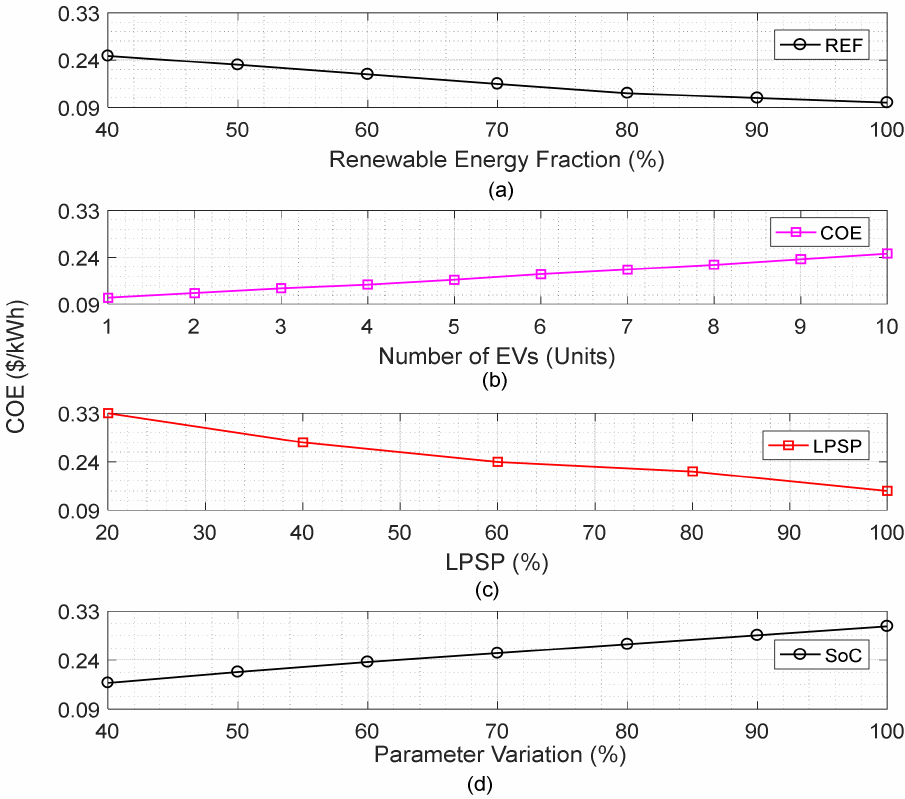
Figure 15. Sensitivity Analysis: ( a ) Comparison of COE and REF of the microgrid system; ( b ) COE against EV increase; ( c ) COE against LPSP, and; ( d ) SoC against the